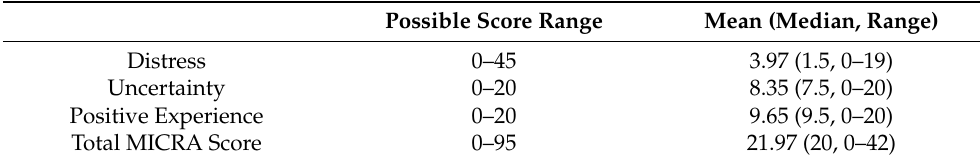
Table 2. Summary of mean scores on MICRA questionnaire (median,